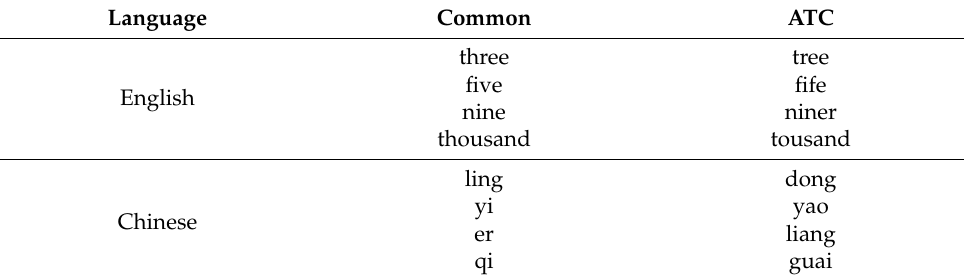
Table 3. Examples of code-switching words in the ATC